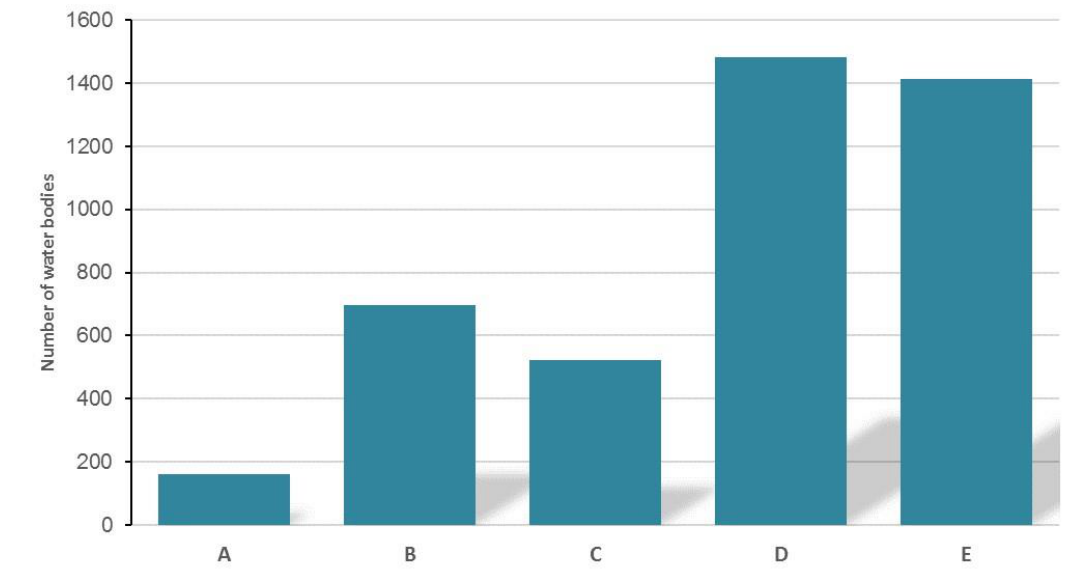
Fig. 6. Number of water bodies provided for specific time periods: A – the beginning of the 19 th century, B – the end of the 19 th century, C – the beginning of the 20 th century, D- the end of the 20 th century, E - the beginning of the 21 st century